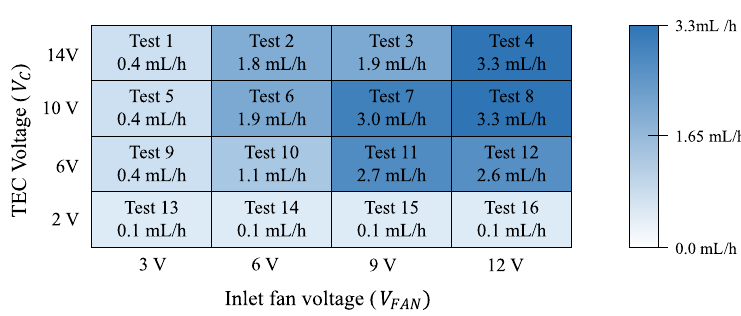
Figure 11. Color map of the consumed power space.